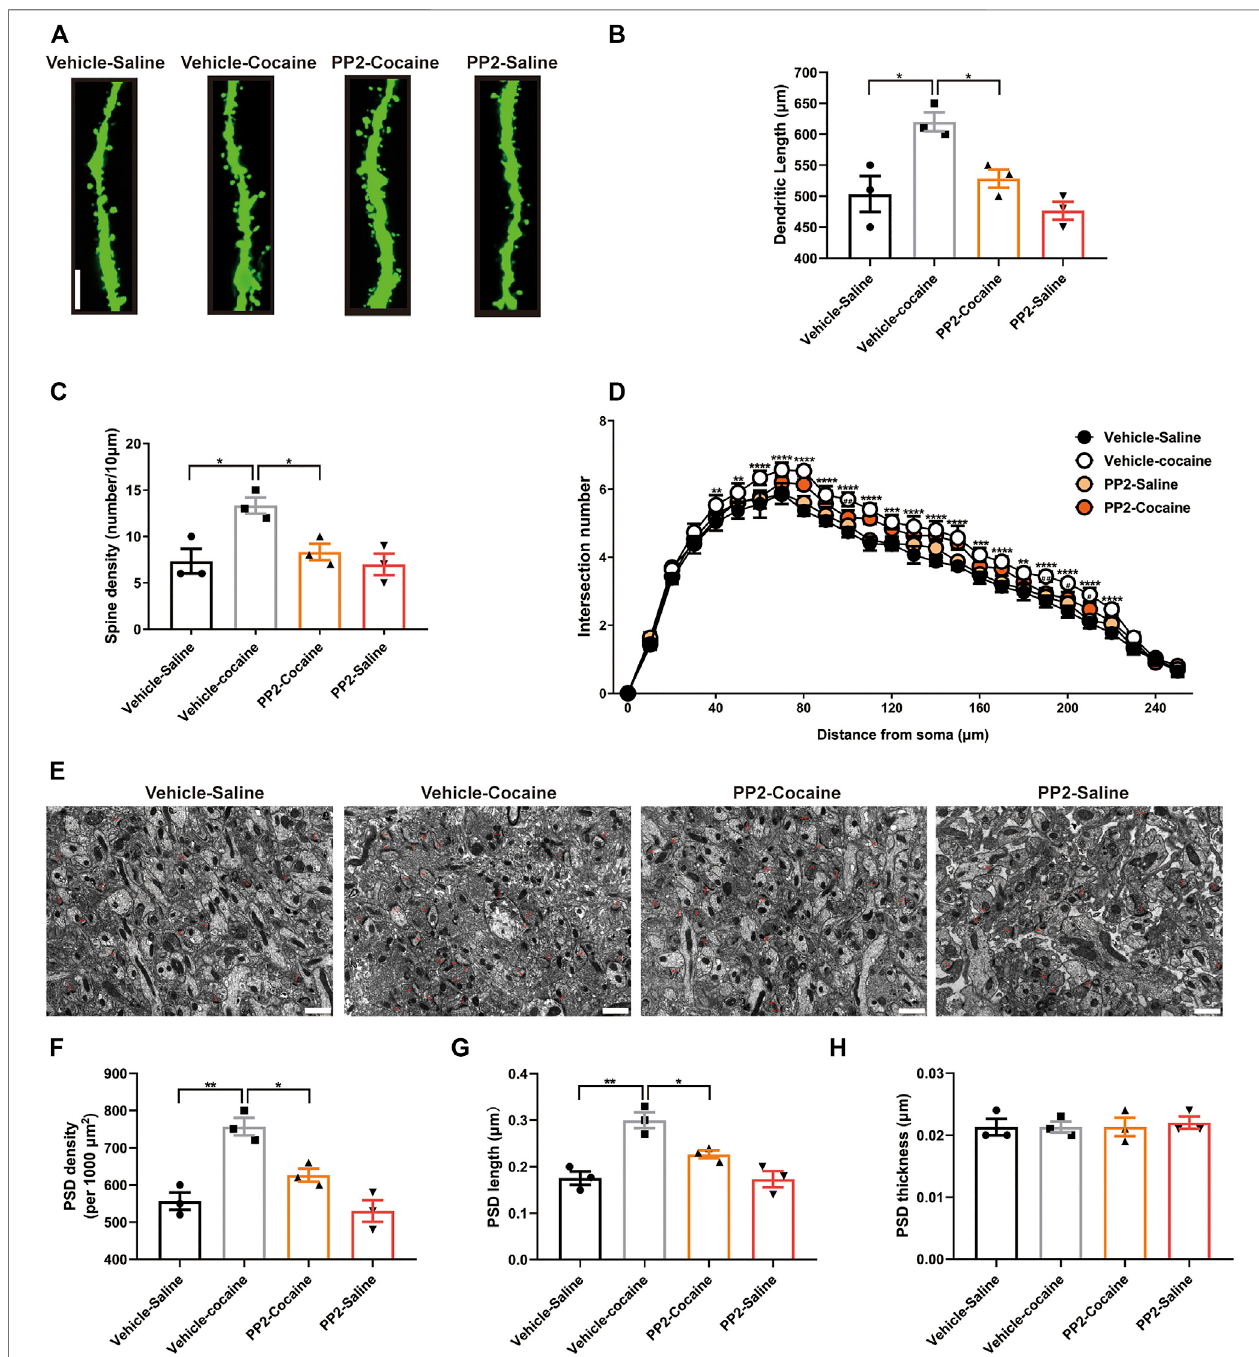
FIGURE4| Cocaineremodelsdendrite structureandsynapsenumbersinhippocampal neuronsdependingonFynactivity. (A) Representativeimagesofdendritic spines in hippocampal neurons (100 × oil lens), Scale bars: 10 μ m. (B) PP2 blockade reduced the dendritic length promoted by cocaine ( n = 3 per group). (C) PP2 blockade obviously attenuated the spine density promoted by cocaine ( n = 3 per group). (D) PP2 inhibited cocaine-induced dendritic arborization ( n = 3 per group). (E) Representative images of the morphology of synapses in the dorsal dentate gyrus region under electron microscopy ( n = 3 per group). (F – H) PSD density and length, but not thickness, were decreased in the hippocampal dorsal dentate gyrus after PP2 pretreatment, as determined by electron microscopy analysis. The red arrowheads indicate synapses. Scale bars: 1 μ m. Data are the means ± SEM, * p < 0.05 and ** p < 0.01.